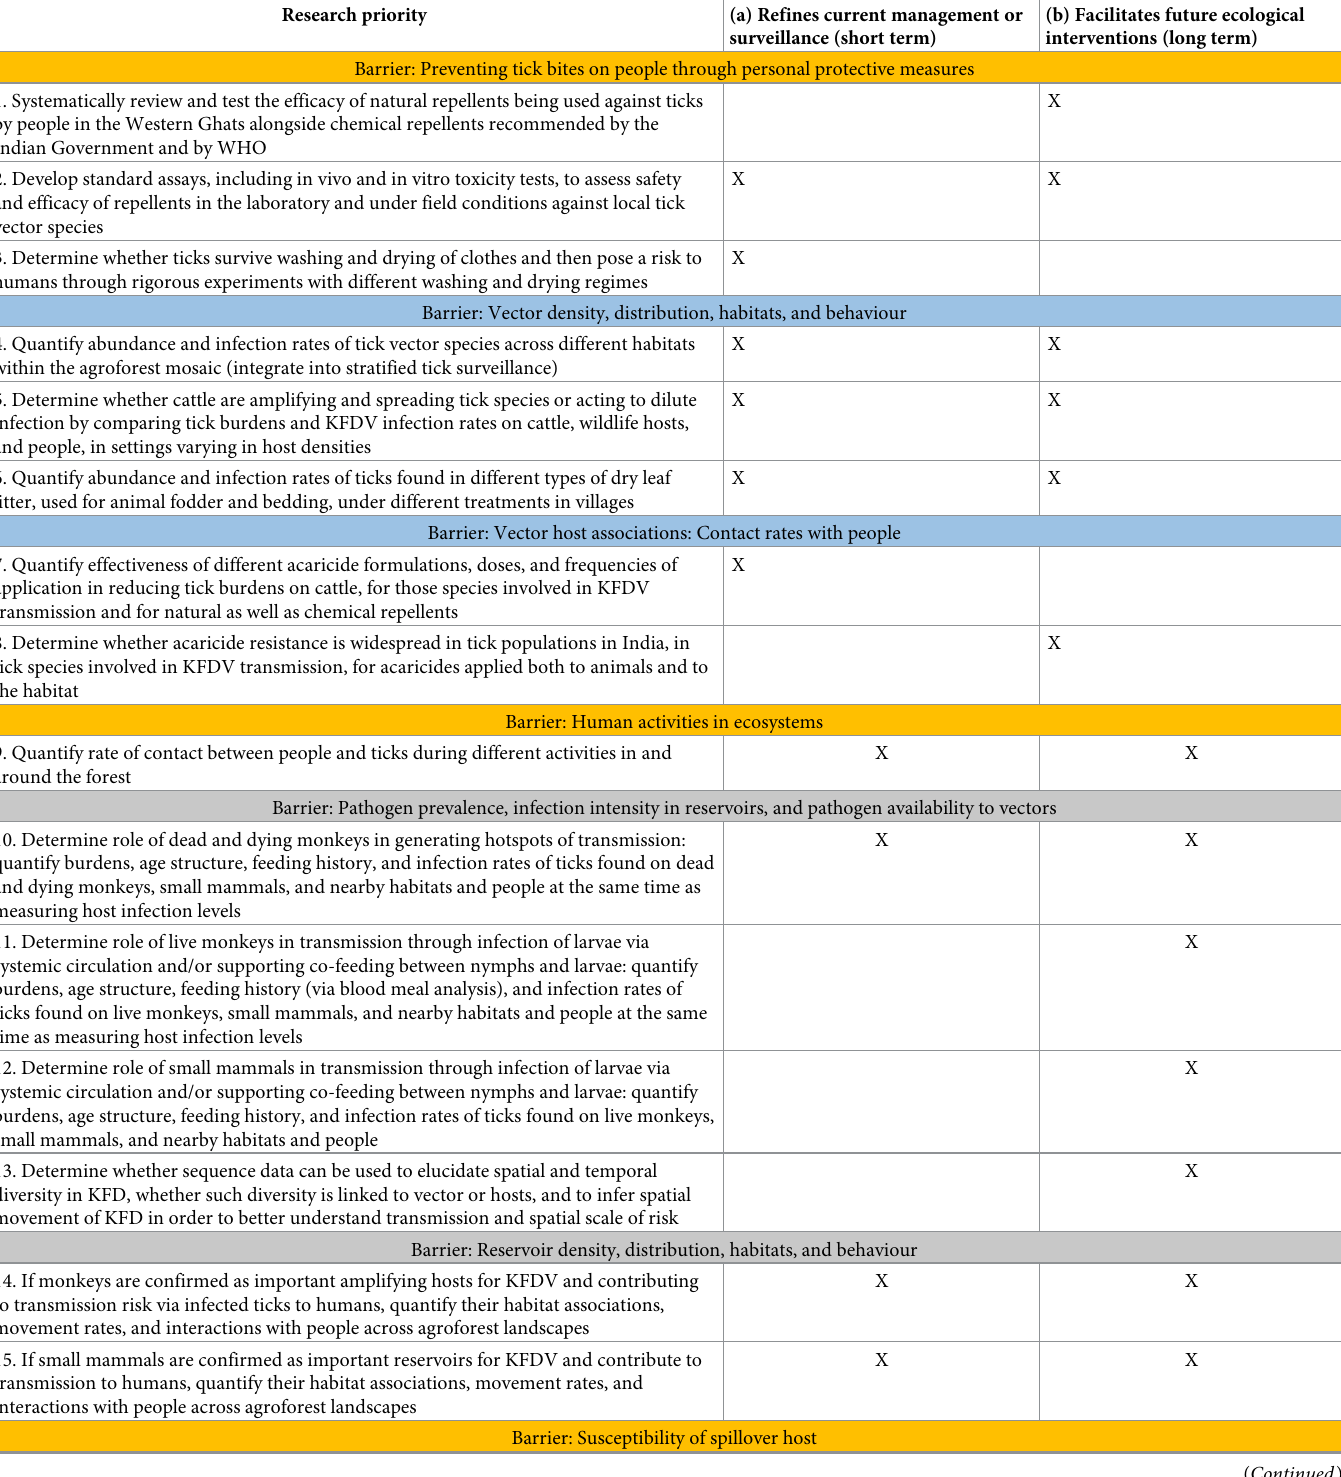
Table 3. Key research priorities under each of the barriers that could be targeted to prevent KFD spillover to humans (Fig 1) and how these would inform and improve existing management strategies (a) and facilitate the development and future implementation of integrated, ecological interventions in the long term (b). Research